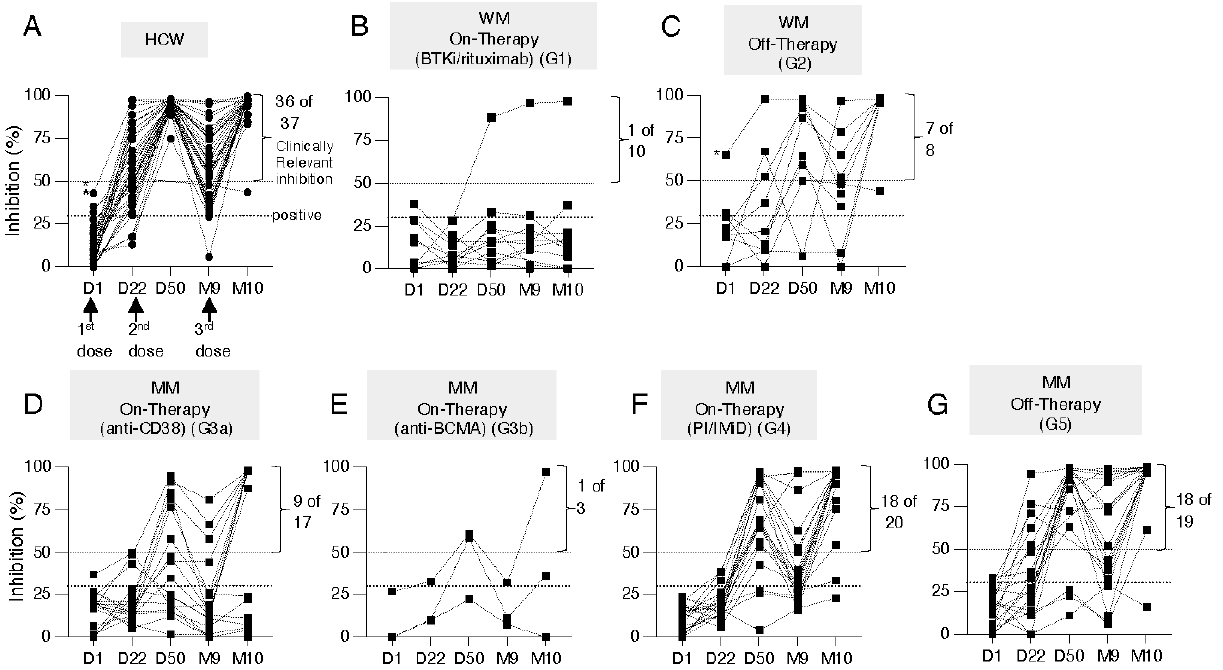
Figure 1. NAb development and kinetics among HCW and patient cohorts. ( A – G ) Kinetics of NAb development using the commercial ELISA (cPass SARS-CoV-2 NAb Detection Kit; Gen-Script, Piscataway, NJ, USA) measuring the % ACE2-binding inhibition of WA1 Spike. Inhibition >30% is con- sidered positive, inhibition >50% has been associated with clinically relevant viral inhibition [28,29], indicated by dotted lines. ( A ) HCW and ( B , C ) WM (G1, G2) and ( D – G ) MM (G3a, G3b, G4, G5) patient cohorts were analyzed at D1, D22 (day of 2nd dose), D50, M9 (day of 3rd vaccination) and one month later at M10. The patient cohorts on active therapy (( B ), G1; ( D ), G3a; ( E ), G3b; ( F ), G4) and off-therapy (( C ), G2; ( G ), G5) are indicated. Asterisks denote one WM patient off-therapy and two HCW individuals with SARS-CoV-2 infection before study entry. The number of samples scoring positive within clinically relevant range of inhibition is given.